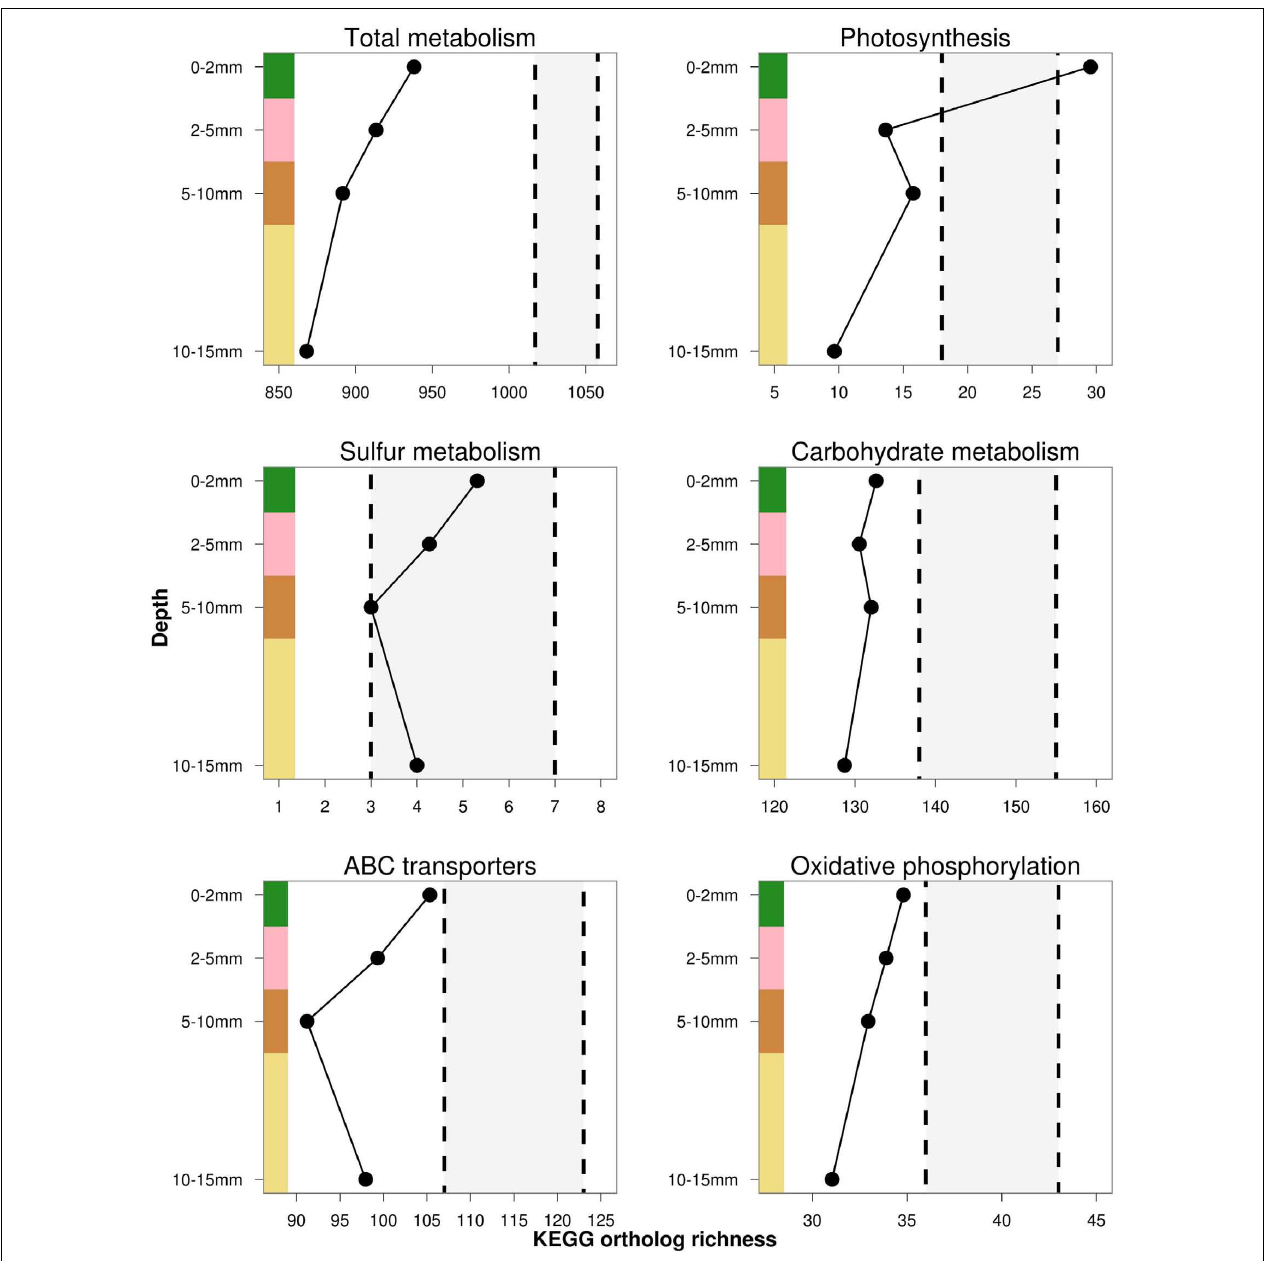
FIGURE 8 | Estimated rarefied KEGG trait richness in the OM-10 core for a subset of functional gene categories. Values falling below or above the shaded regions indicate significantly fewer ( α = 0.05) or greater trait richness than expected under 1,000 null model randomizations,